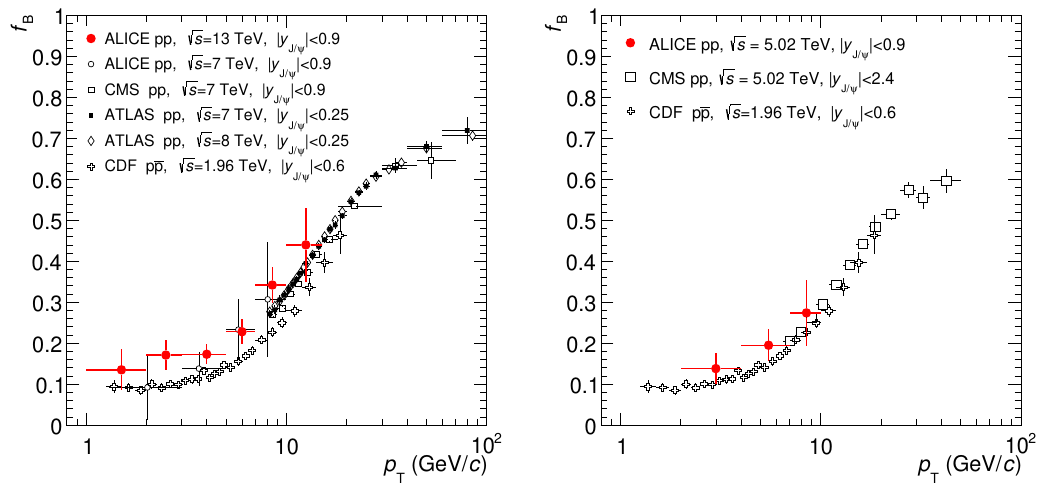
Figure 2 . Non-prompt J /ψ fraction as a function of p T measured by the ALICE collaboration in √ pp collisions at s = 13 TeV (left panel) and 5.02 TeV (right panel) compared with similar results obtained at midrapidity in pp collisions at the LHC, namely CMS [18, 24] and ATLAS [29]. The √ results from CDF in proton-antiproton collisions at s = 1.96 TeV [1] are also shown in both panels. Error bars correspond to the quadratic sum of statistical and systematic